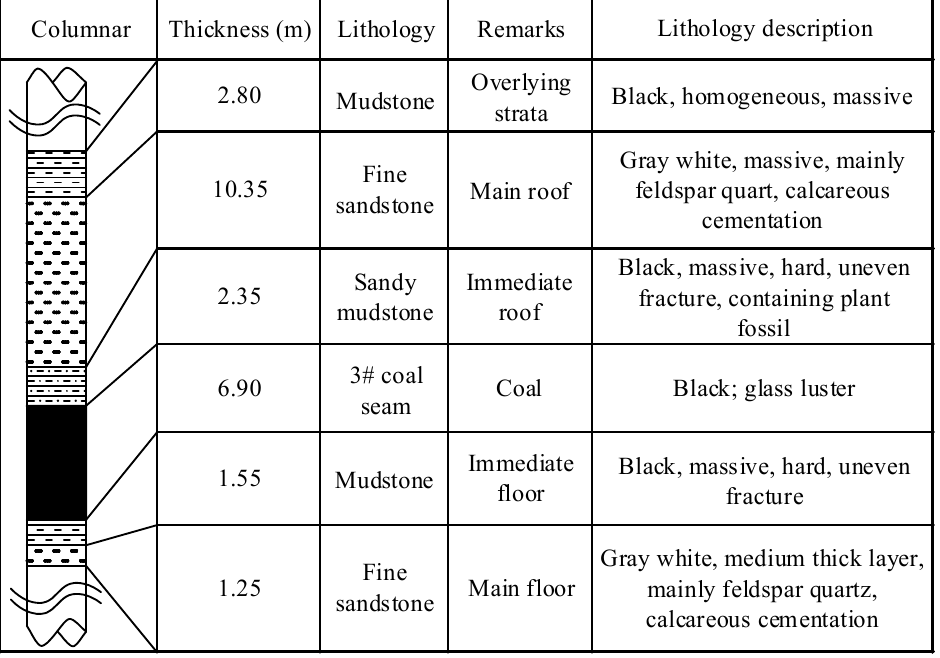
Figure 3. Stratigraphic column and geological description.